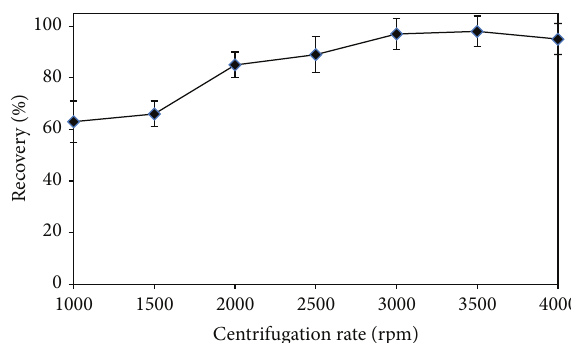
Figure 5: Effect of centrifugation rate (rpm) on the recovery (%) of the DLLME procedure for Bi(III)